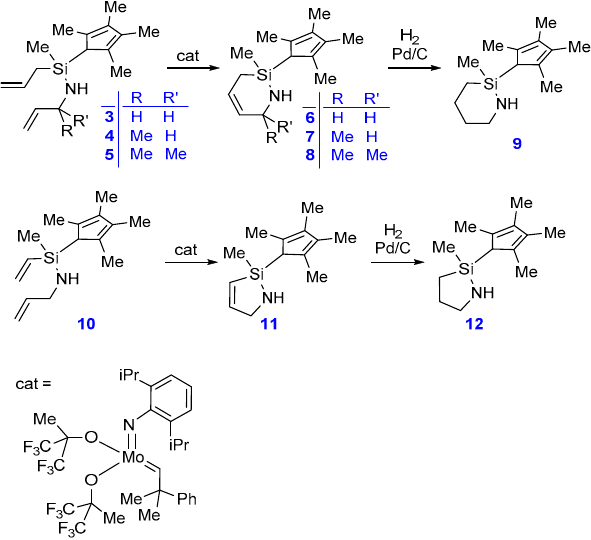
Scheme 1. Construction of the ligand frameworks for the targeted complexes.